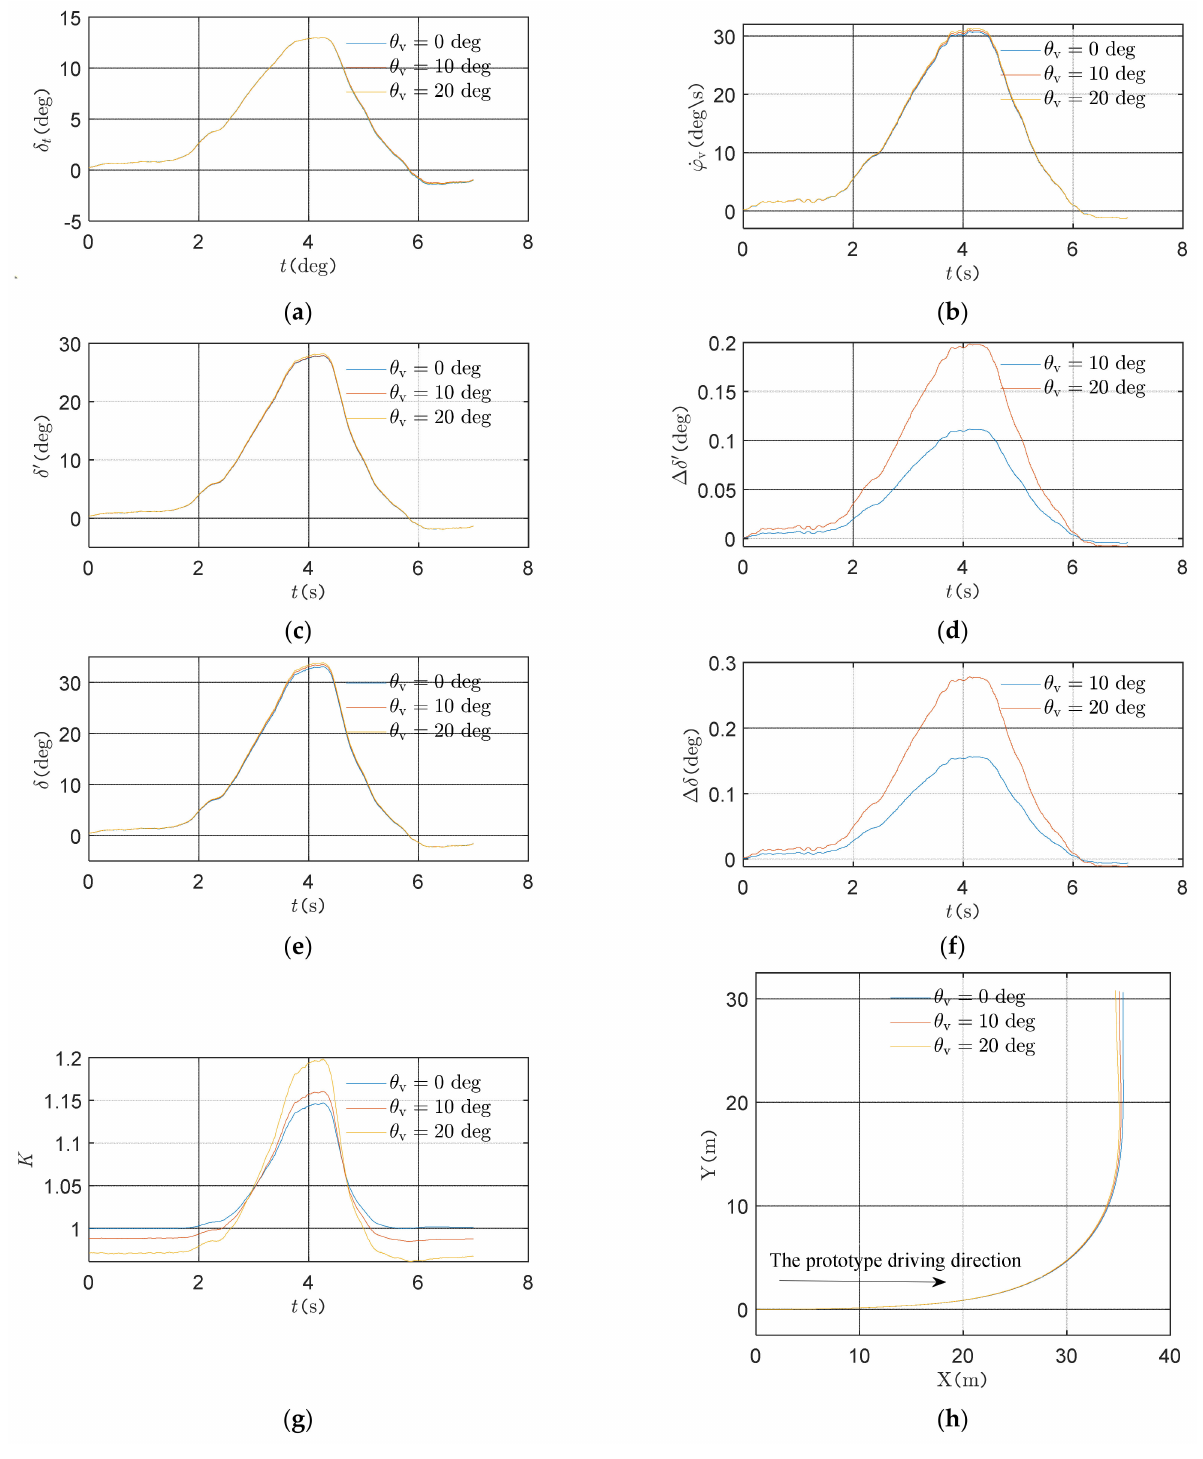
Figure 10. The result of the experiment. ( a ) Entered steering information; ( b ) the yaw rate of the prototype; ( c ) steering angle of the left wheel; ( d ) steering angle of the right wheel; ( e ) steering angle error of the left wheel; ( f ) steering angle error of the right wheel; ( g ) the SGCR; ( h ) the